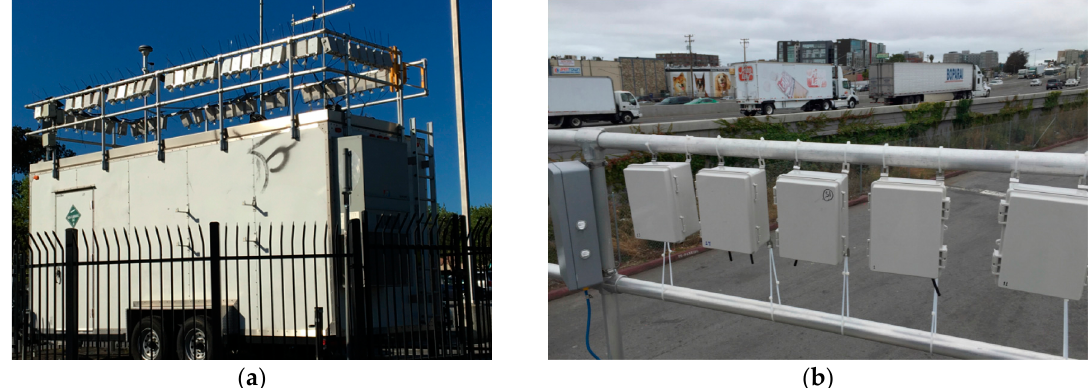
Figure A1. ( a ) Over 60 ABCDs hung from the roof railing of the Bay Area Air Quality Management District roadside monitoring station in Oakland, California; ( b ) Close up view of ABCDs deployed at the monitoring station, with California Highway 880 in the background.